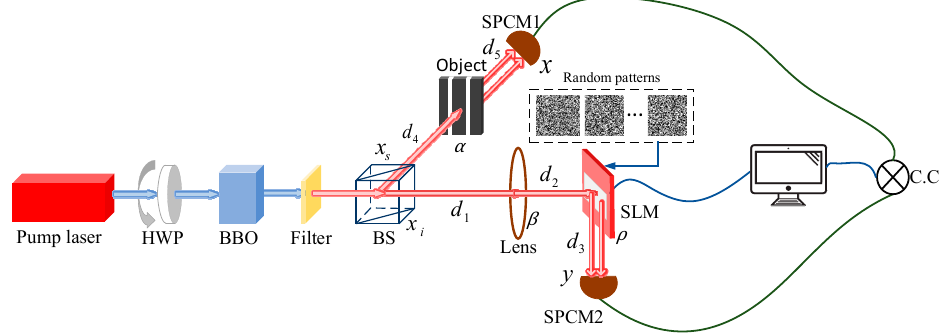
Figure 1. The experimental schematic of STLS quantum GI: HWP, half-wave plate; BBO, β -barium borate crystal; BS, beam splitter; Random patterns placed on a spatial light modulator (SLM); SPCM, single photon counting modules; C.C, coincidence measurement between SPCM1 and SPCM2.